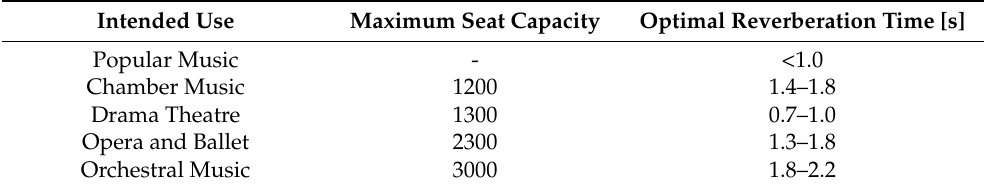
Table 3. Optimal reverberation time according to the intended use of the environment.